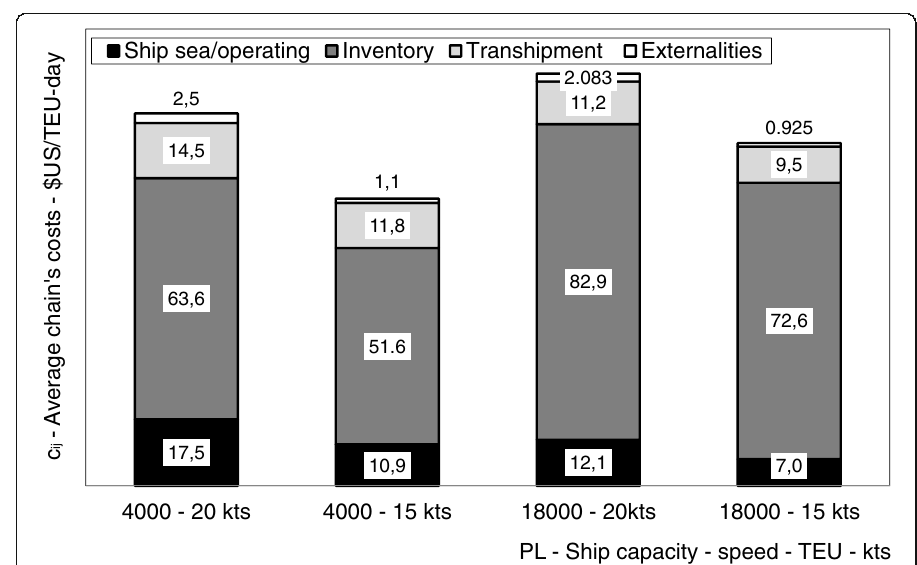
Fig. 10 The indicators of economic performances of the given trunk line/route - Structure of the average